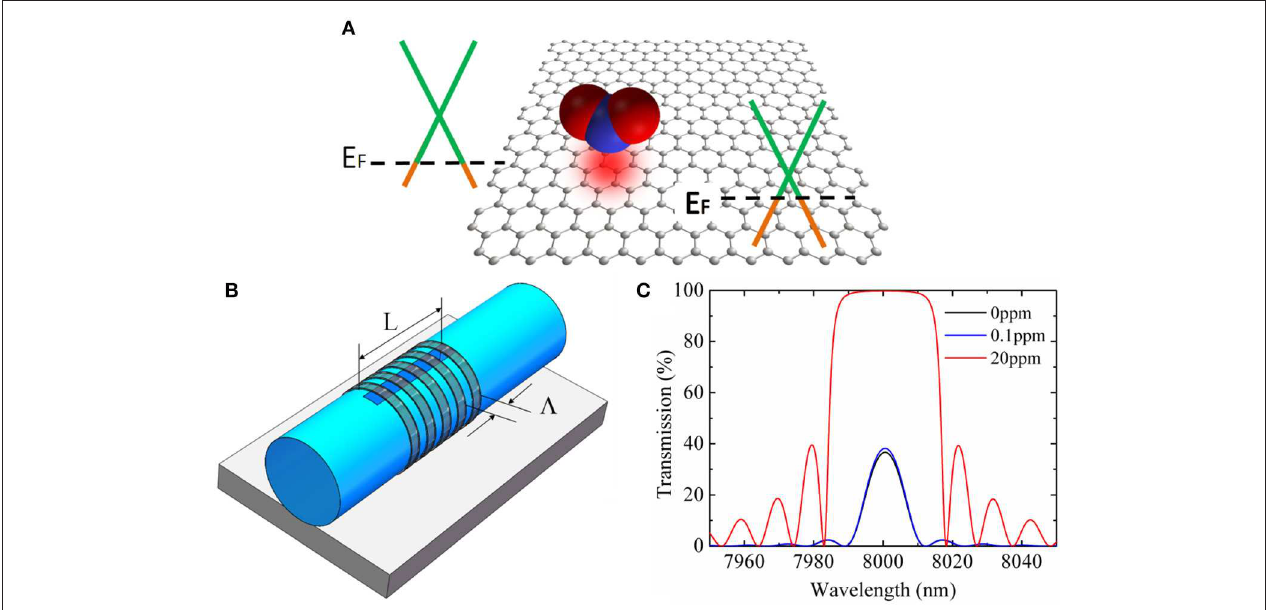
FIGURE 1 | Design of graphene-based photonic chemical sensors. (A) Schematic of the variation of Fermi level induced by the adsorbed molecules on graphene. (B) Design of the silicon fiber-integrated graphene photonic gas sensor. (C) Reflection spectra of the graphene Bragg grating structure for sensing NO 2 gas. The black, blue, and red curves represent the Bragg grating reflection spectra at 0, 0.1, and 20 ppm NO 2 gas concentrations, respectively. Figures 1B,C are reprinted with permission from Ref. [7]. Copyright © 2019 IEEE.